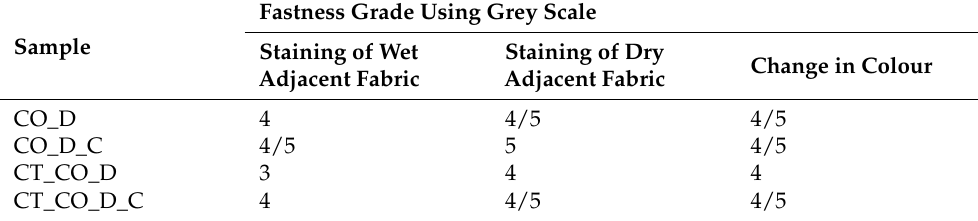
Table 7. Colour fastness to hot